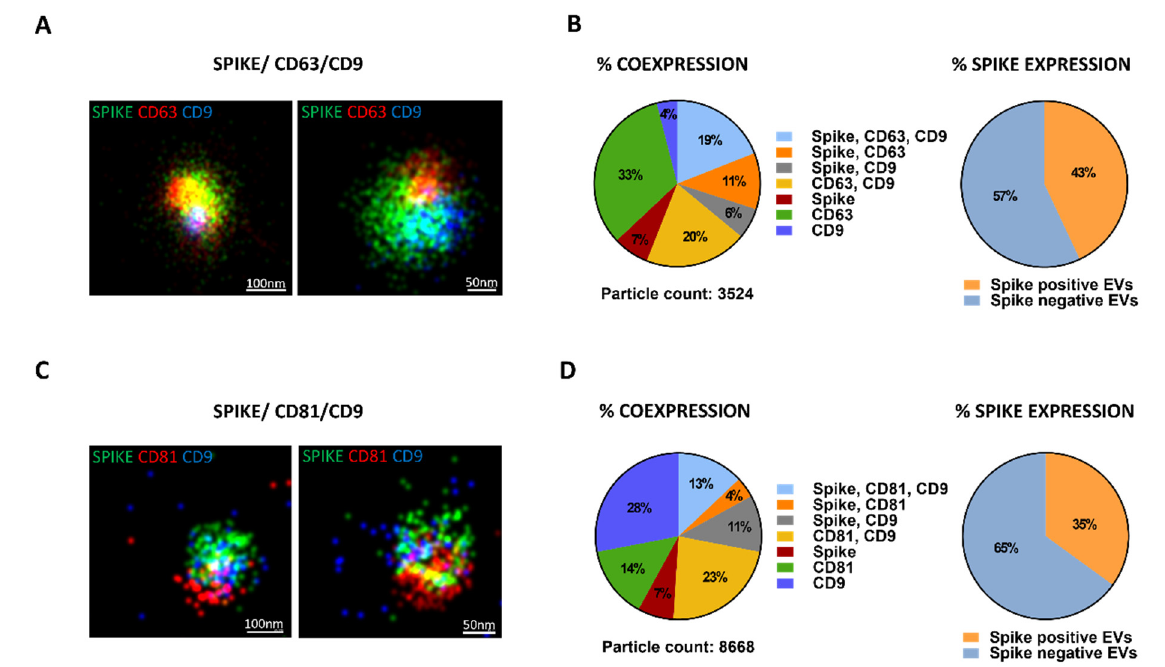
Figure 3. Super-resolution microscopy analysis of EVs isolated from H-S. ( A ) Super-resolution microscopy micrographs showing the pattern distribution of spike in green, CD63 in red and CD9 in blue (Spike/CD63/CD9) for S-EVs. ( B ) The percentage of EVs in triple, double or single positivity for spike, CD63, CD9 markers (% coexpression) and the total per- centage of EVs positive or negative for spike protein (% spike expression) was reported. ( C ) Super-resolution microscopy micrographs showing the pattern distribution of spike in green, CD81 in red and CD9 in blue (Spike/CD81/CD9) for S- EVs. ( D ) The percentage of EVs in triple, double or single positivity for spike, CD81, CD9 markers (% coexpression) and the total percentage of EVs positive or negative for spike protein (% spike expression) was reported.